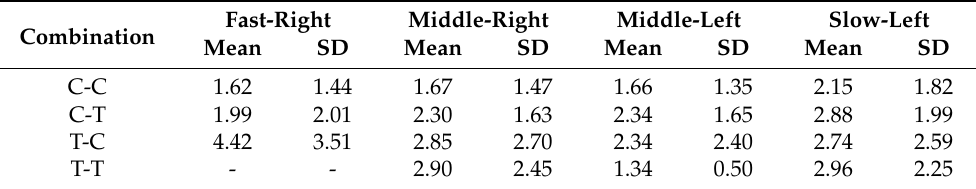
Table A11. The mean and standard deviation of THW of m and n1.